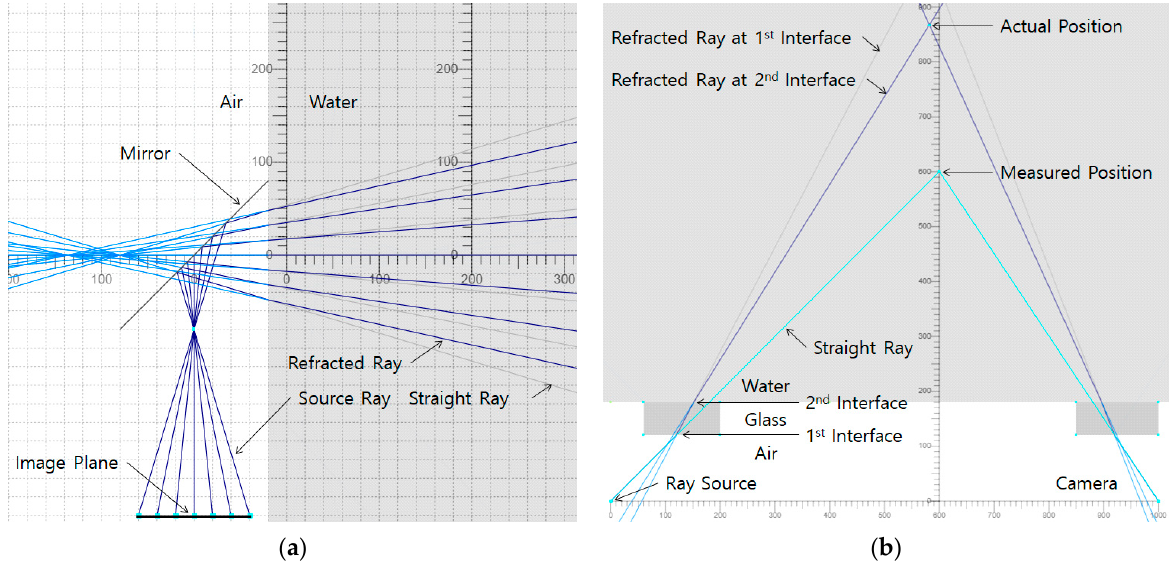
Figure 1. Ray Optics Simulation: ( a ) Vertical Plane; ( b ) Horizontal Plane.